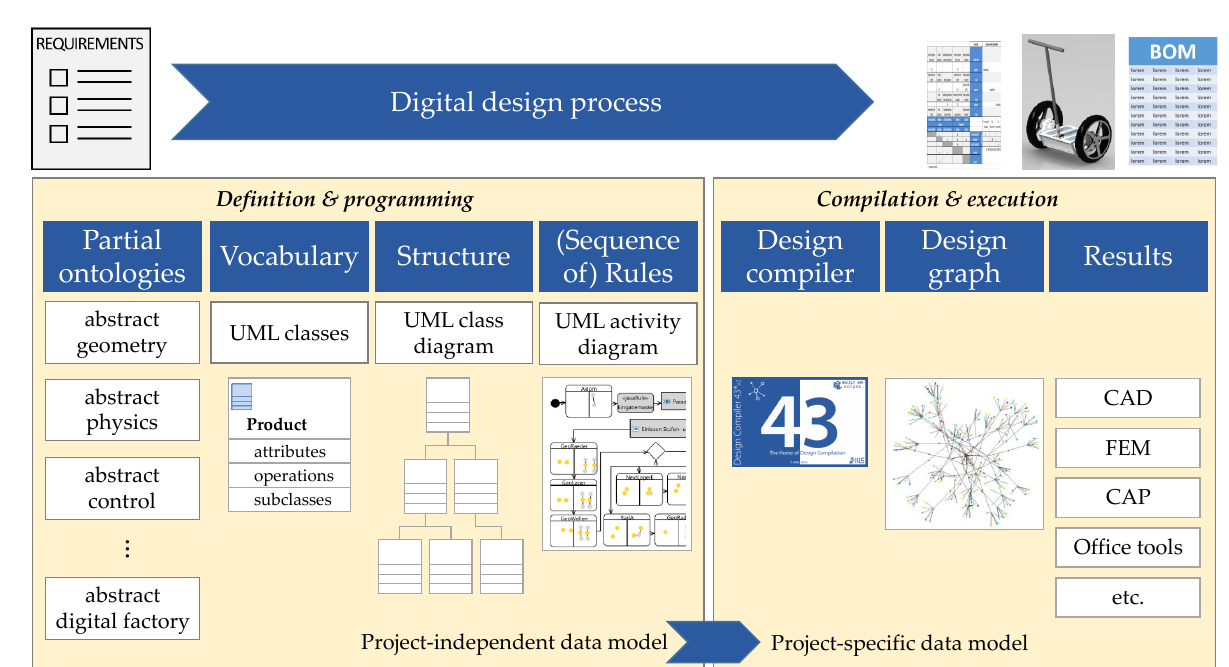
Figure 4. Concept of a graph-based design